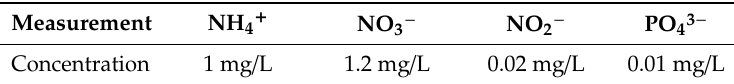
Table 2. Simulated rainfall